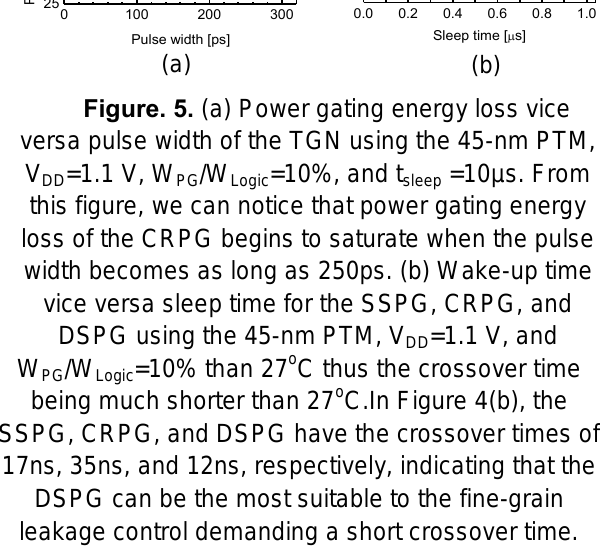
Figure 3: A 31-stage ring oscillator (a) delay vs. voltage supply (b) power and delay product vs. voltage supply.